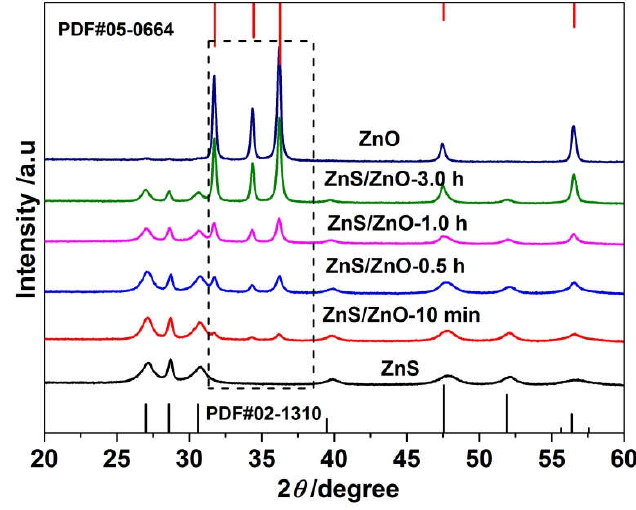
Figure 2. XRD diffractions patterns of the samples obtained via calcination of ZnS(en) 0.5 at 500 °C for different times including 5 min, 10 min, 0.5 h, 1.0 h, 3.0 h and 5.0 h.